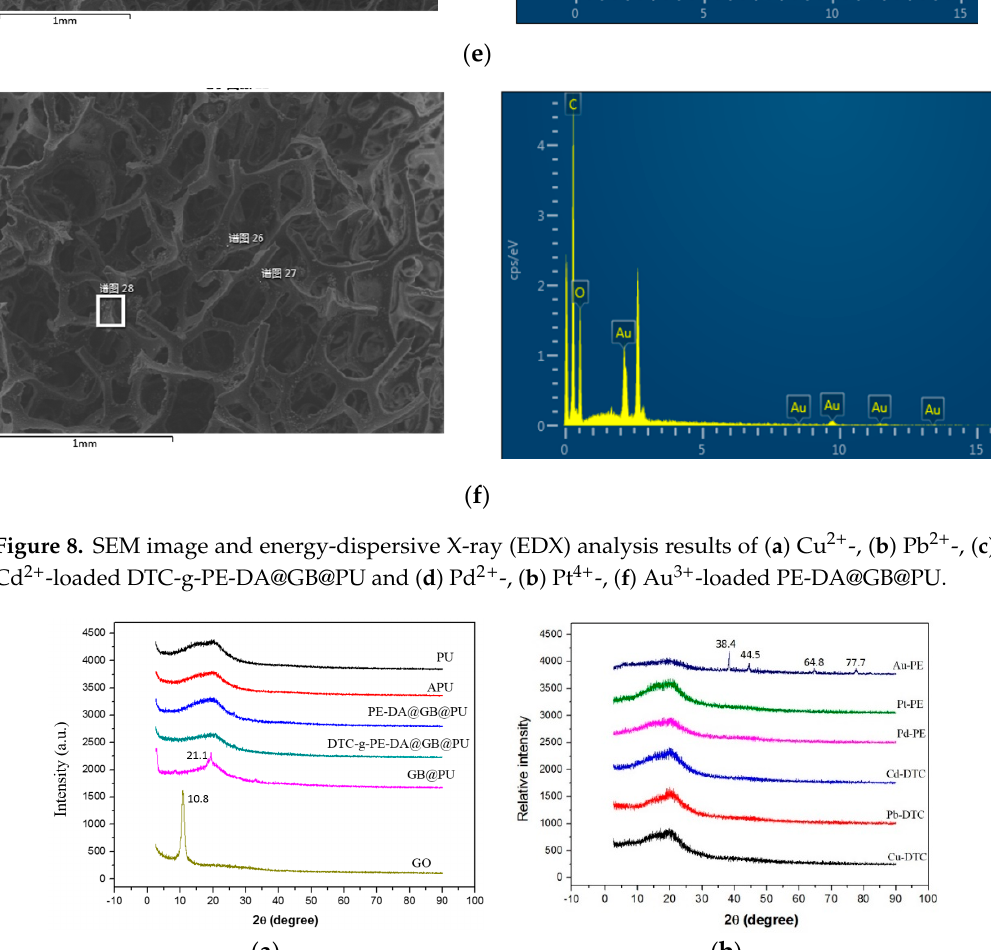
Figure 8. SEM image and energy-dispersive X-ray (EDX) analysis results of ( a ) Cu 2+ -, ( b ) Pb 2+ -, ( c ) Cd 2+ -loaded DTC-g-PE-DA@GB@PU and ( d ) Pd 2+ -, ( b ) Pt 4+ -, ( f ) Au 3+ -loaded PE-DA@GB@PU.